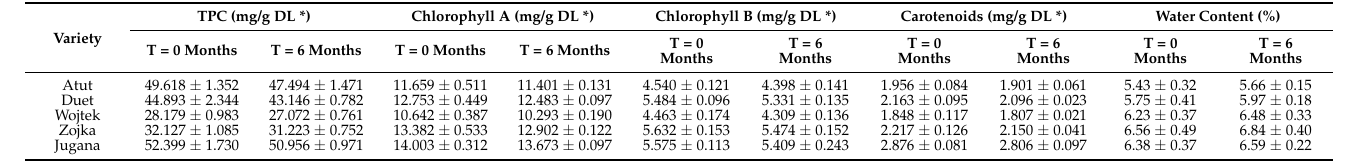
Table 2. Quantitative evaluation of haskap berry leaves at the begging and after 6